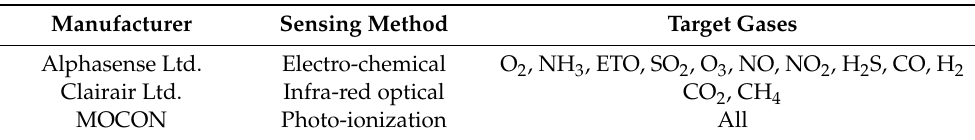
Table 2. Sensors deployed in Wolf eNose.